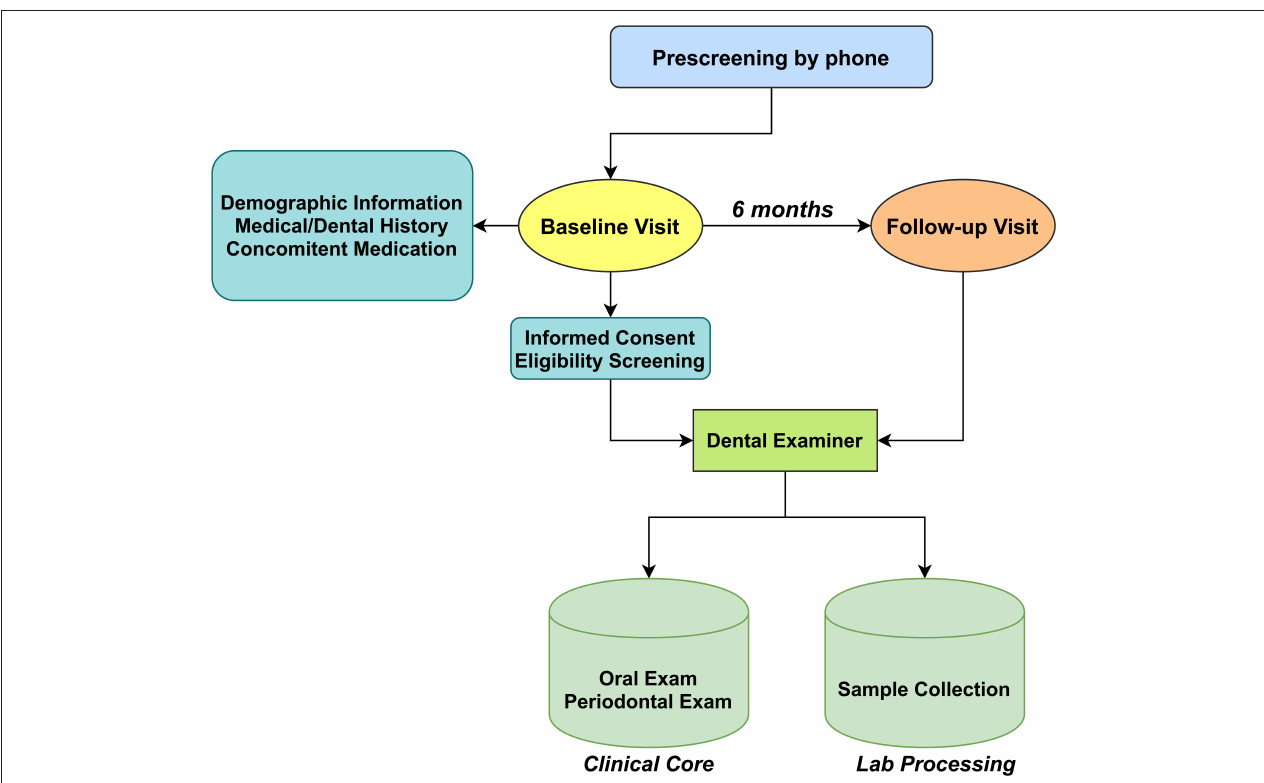
FIGURE 1 | Schematic showing the flow of subject recruitment and sample collection. The types of samples collected and their transit from collection points to a processing laboratory where they were labeled and entered into a